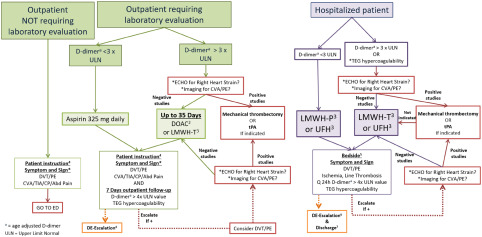
VTE/PE Thromboprophylaxis Clinical Guidelines for SARS-nCoV-2 PCR+/IgM+ (COVID+) or Person Under Investigation1